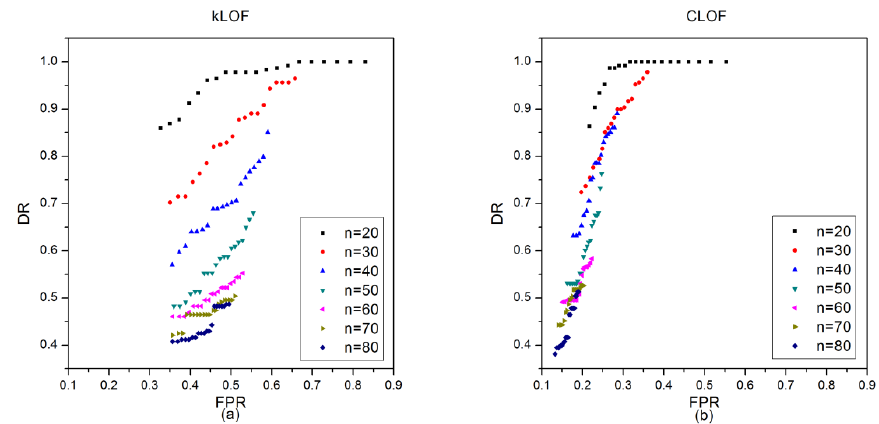
Figure 12. ROC curves of kLOF and CLOF methods on the KDD Cup 1999 dataset with different n related to t : ( a ) the ROC curves of kLOF method; ( b ) the ROC curves of CLOF method.